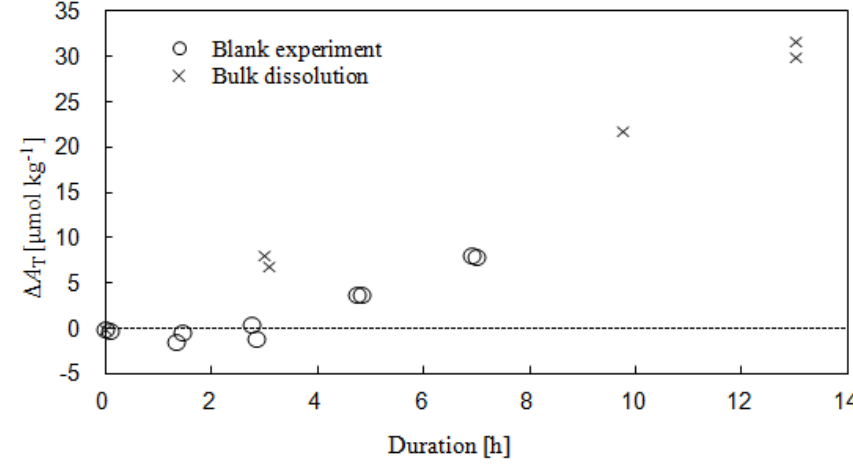
Fig. 3. Blank experiment and bulk dissolution (before salinity calibration).